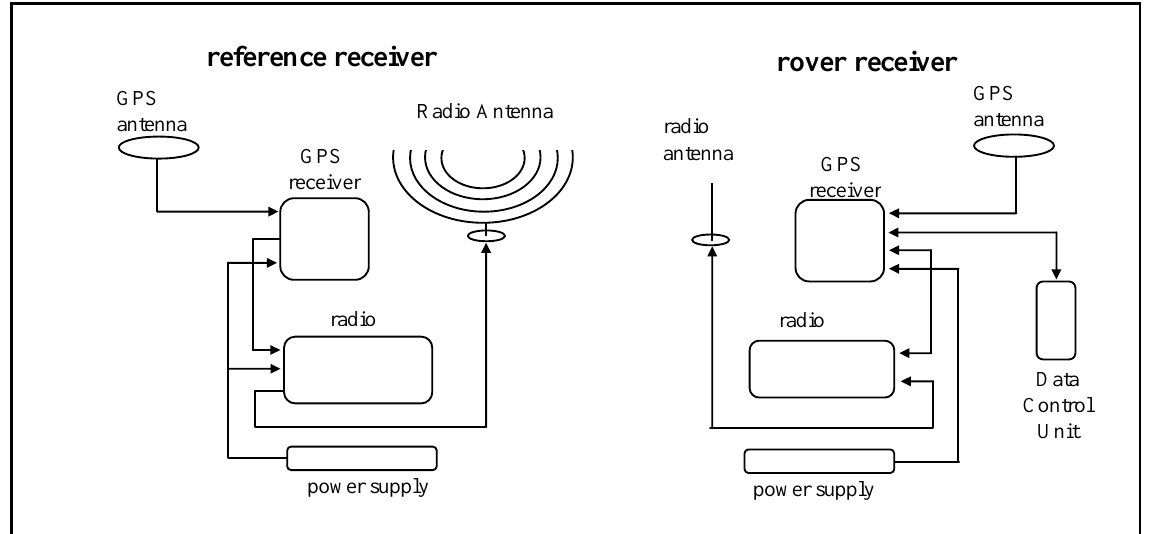
Figure 1 . A typical structure of RTK